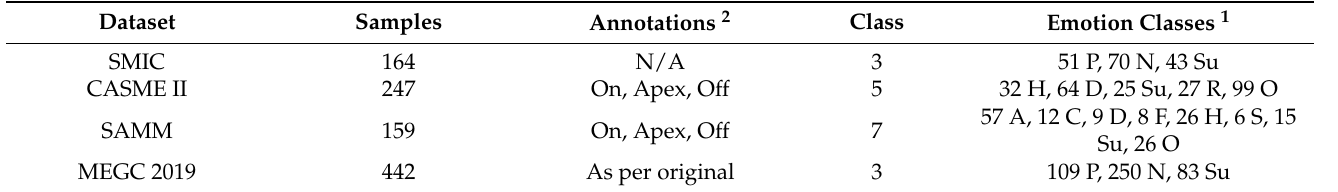
Table 1. Micro-expression